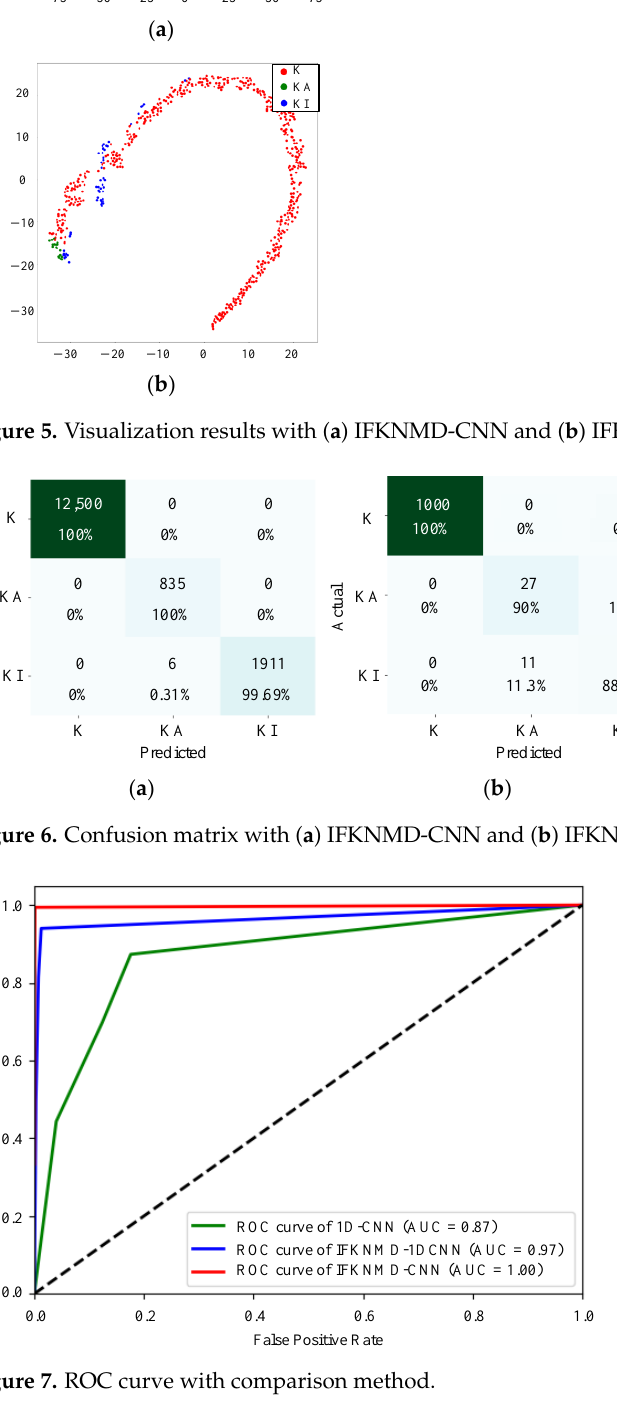
Figure 7. ROC curve with comparison method.